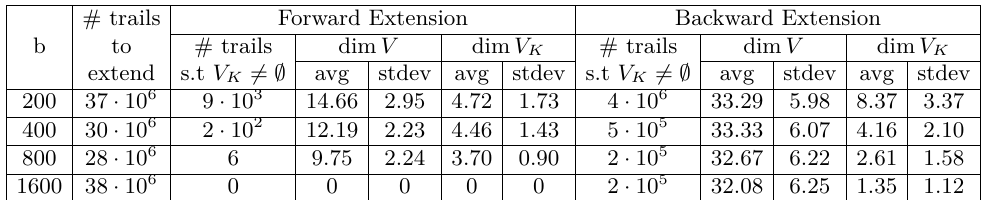
Table 2: Results on extension in the kernel. Column two gives the total number of trail cores to extend (both in the forward and backward direction). For both the directions we report the number of trail cores for which V K is not empty and for such trails the average dimension of V and V K